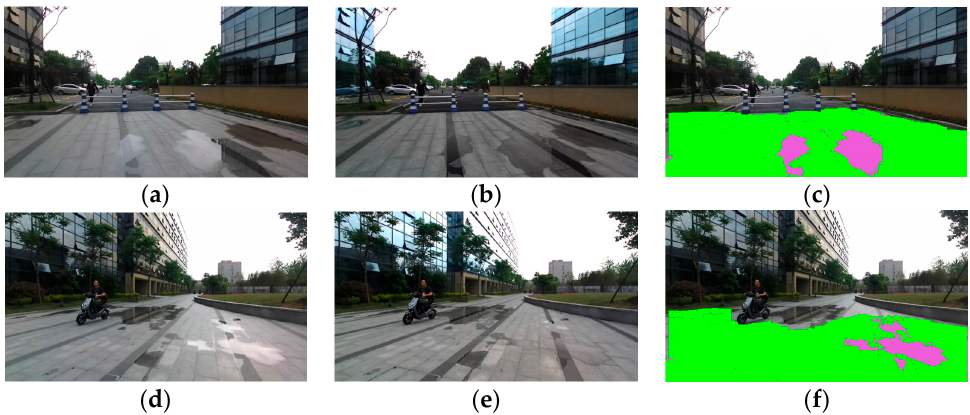
Figure 6. Water hazard detection with traversable area detection. ( a , d ) Left color images; ( b , e ) Right color images; ( c , f ) Detection results with the pRGB-D sensor.